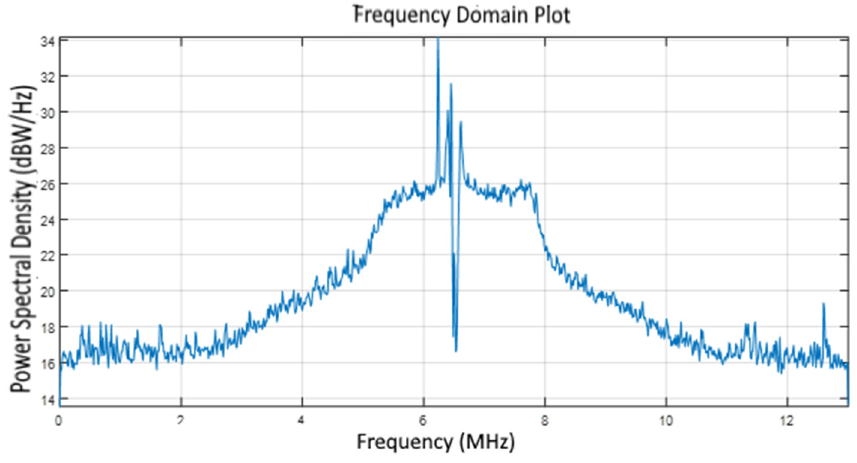
Figure 23. Frequency spectrum of VHDL implementation (fixed-point with 16-precision) .